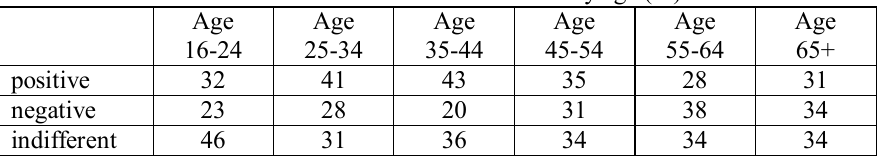
Table 4 – Attitudes towards Irish by age